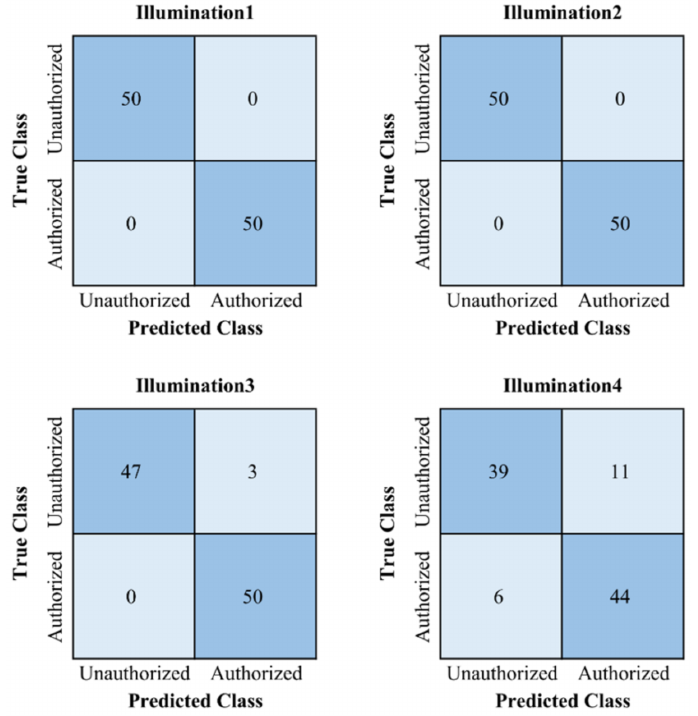
Figure 19. The confusion matrix of VggNet under different illuminations.